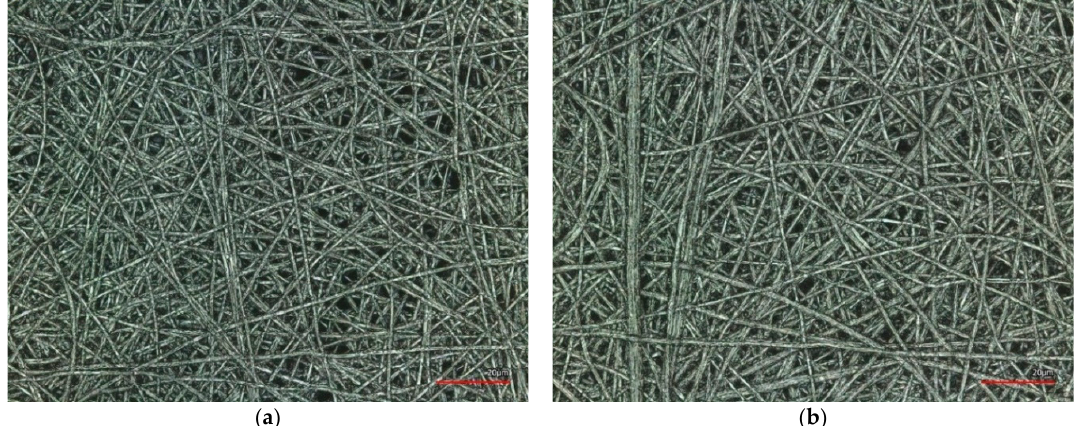
Figure 12. Confocal Laser Scanning Microscope (CLSM) image of PLA object, sample—7. Scale bar indicates 200 μ m.